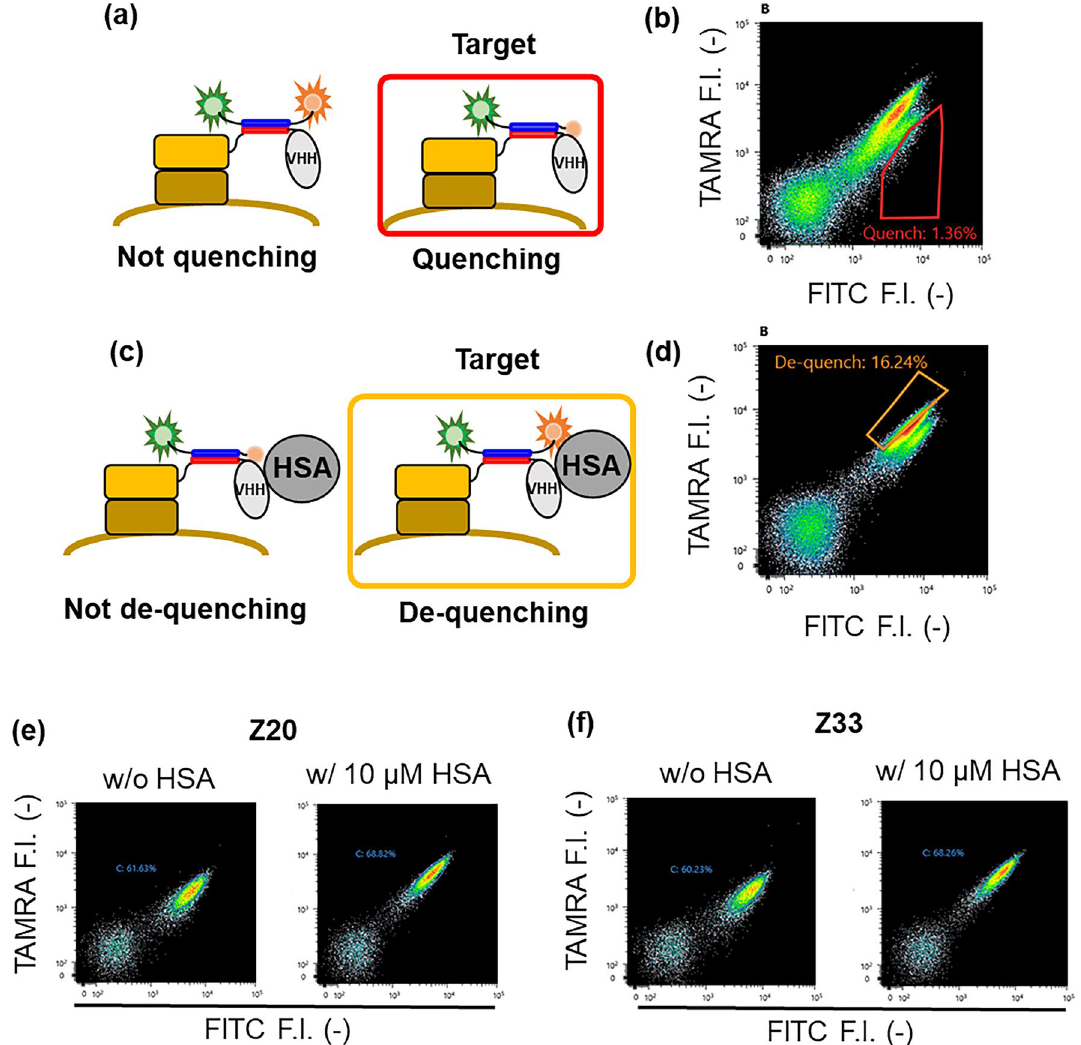
Figure 4. Selection of potent anti-HSA mini Q-body displayed on the yeast cell surface. ( a , c ) Schematic image of selection steps for quenching clones ( a ) and de-quenching clones ( c ). ( b , d ) Flow cytometric analysis in the selection of quenching clones ( b ) and the selection of de-quenching clones ( d ). Each clone was selected by the red gate or the yellow gate respectively. ( e , f ) Flow cytometric analysis of selected yeast displayed anti-HSA mini Q-bodies Z20 ( e ) and Z33 ( f